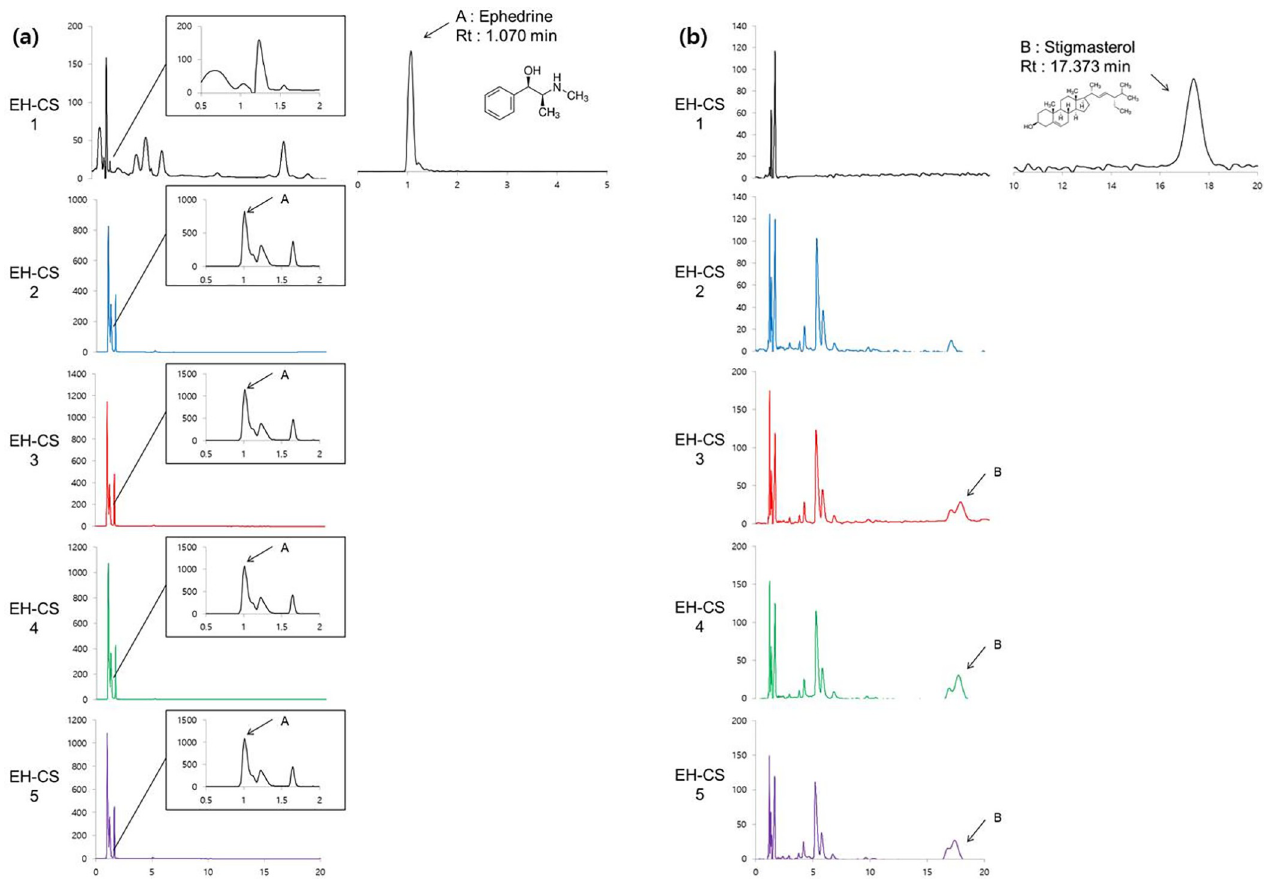
Fig 1. (a) HPLC analysis results for EH-CS samples and standard (Ephedrine) in isocratic condition (A–water with 0.05% formic acid and B–acetonitrile) of A: B = 50:50. Ephedrine was identified at a retention time of 1.070 min. (b) HPLC analysis results for EH-CS samples and standard (Stigmasterol) in isocratic condition (A–water with 0.05% formic acid and B–acetonitrile) of A:B = 95:5. Stigmasterol was identified at a retention time of 1.737